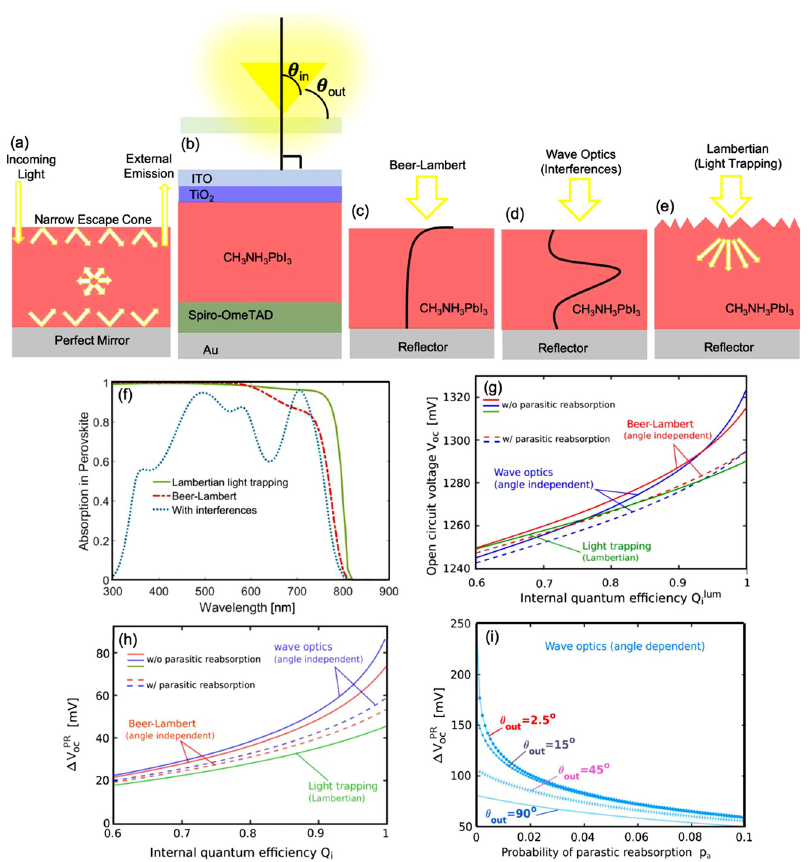
Figure 5: (a) Schematic diagram of optically ideal solar cell structure for efficient photon recycling with no optical loss (No reflection from the frontsideandperfectlyreflectedfromthebackside).Photonsaretrappedduetothenarrowerescape-coneangleandreabsorbedandre-emitted withintheactivelayer.Moreover,whentheescape-coneangleisnarrowerthantheemissionangle,theemittedphotonswillbereflectedfromthe cell ’ s front surface. (b) Schematic representation of layer stack [ITO(150 nm)/TiO 2 (20 nm)/CH 3 NH 3 PbI 3 (300 nm)/Spiro-OmeTAD(250 nm)/ Au(60 nm)] of PSCs considered in the photon recycling calculation by Abebe et al. [31]. θ in is the incident angle of incoming light and θ out is the anglerelativetothesurfacenormali.e.,de fi